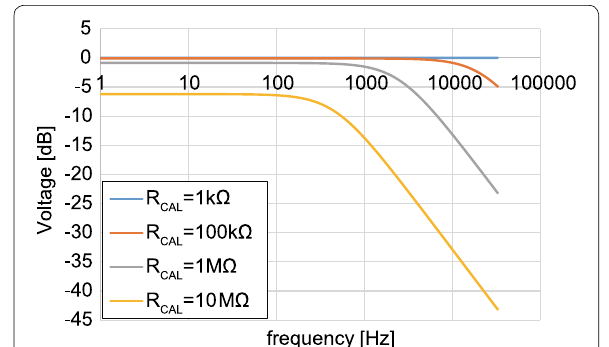
Fig. 15 A simulation result of the divided voltage at the point V 1 in Fig.